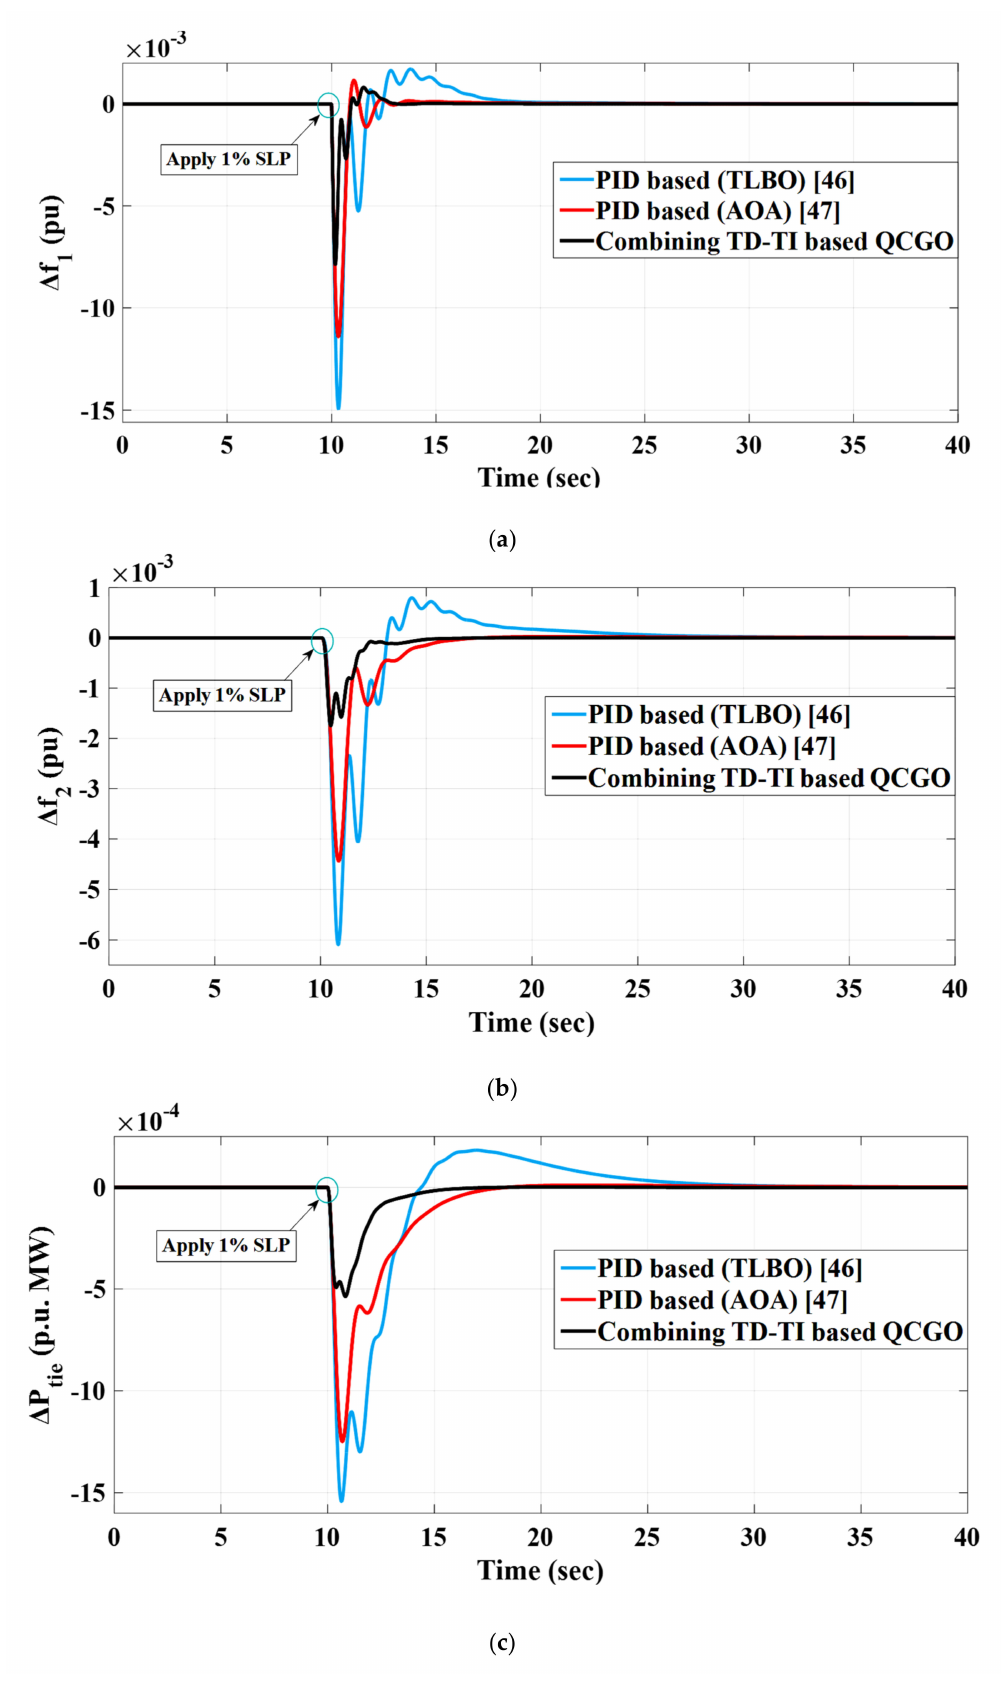
Figure 14. Dynamic power grid responses in case A.1.1: ( a ) ∆ f